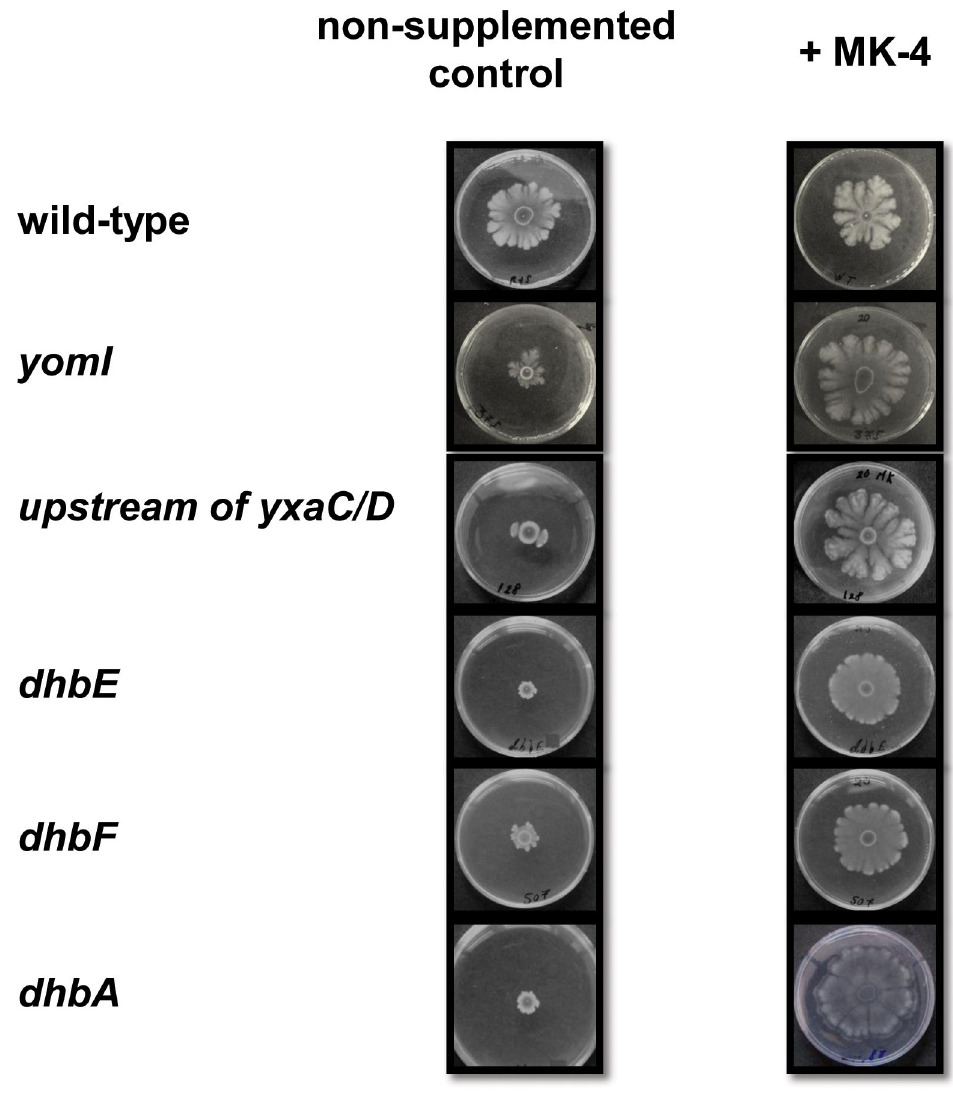
Figure 4. Reconstitution of complex colony development by addition of MK-4. Three μl of a fresh overnight culture were spotted onto the center of spreading plates containing 1.2% agar (left) and spreading plates containing 1.2% agar supplemented with 40 μg/ml MK-4 (right) and incubated at 37°C in a humid and dark environment. Plates were photographed after 72 hours. The presented results are representative of at least five independent